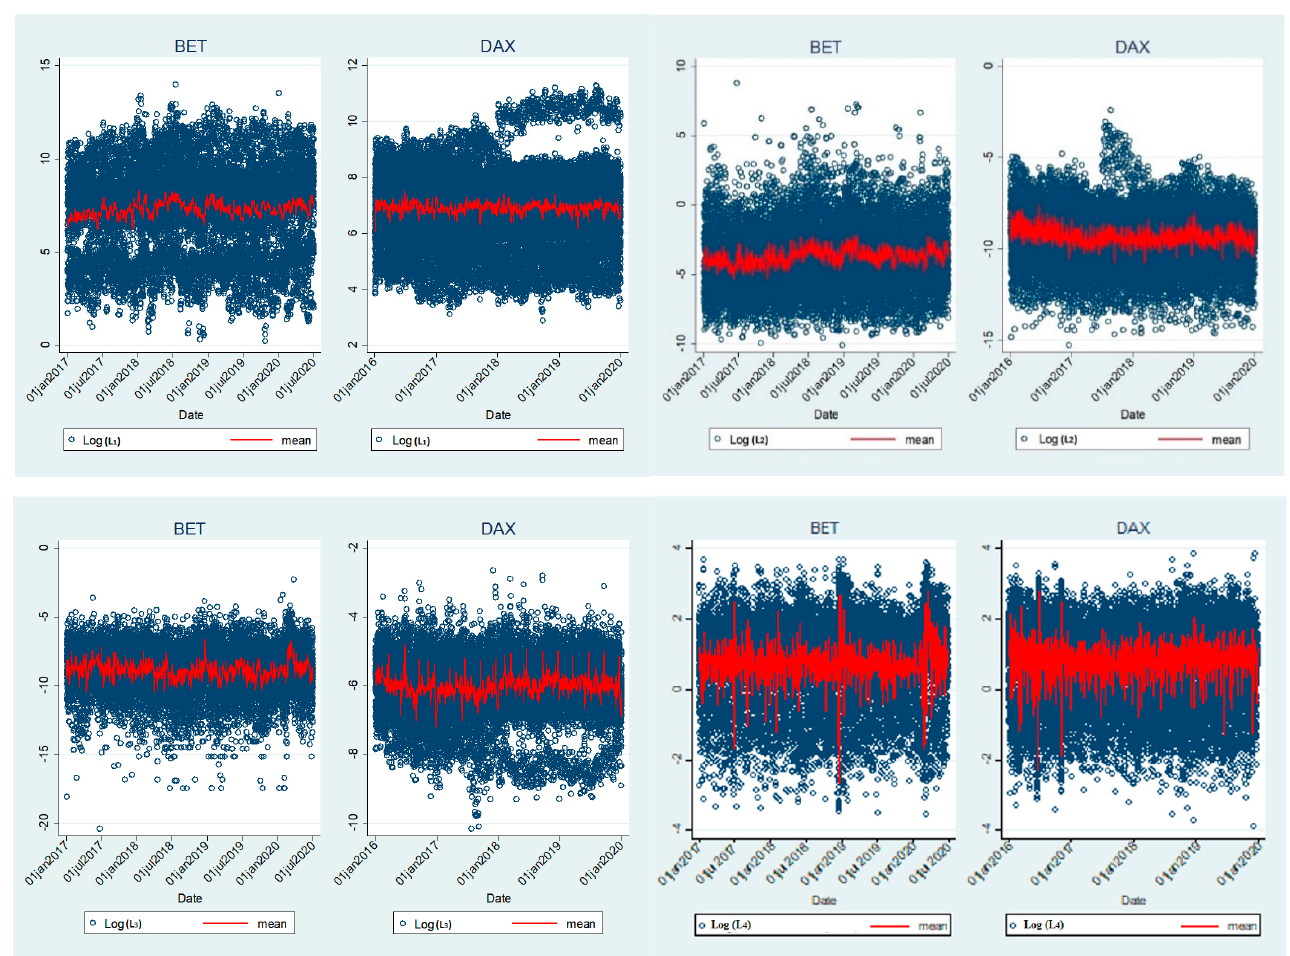
Figure 1. Dynamics of liquidity ratios at company level and their average throughout the analysis period. Notes: BET-